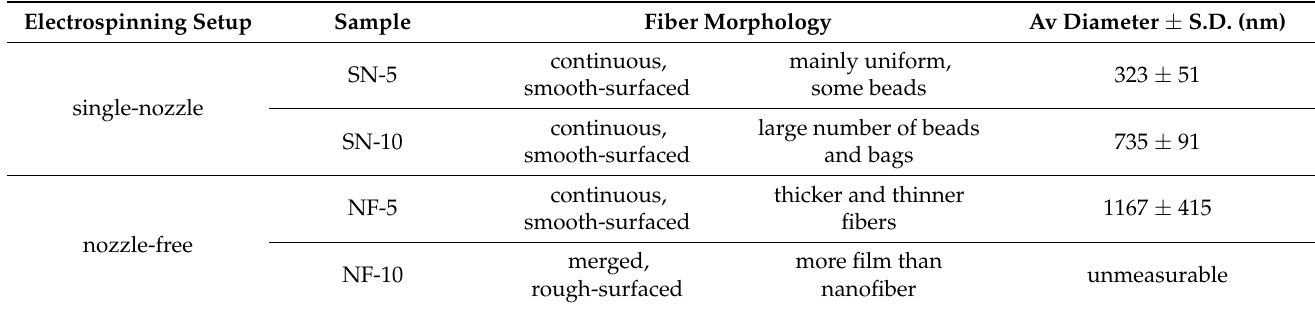
Table 3. Fiber morphologies and average diameters of different formulations.